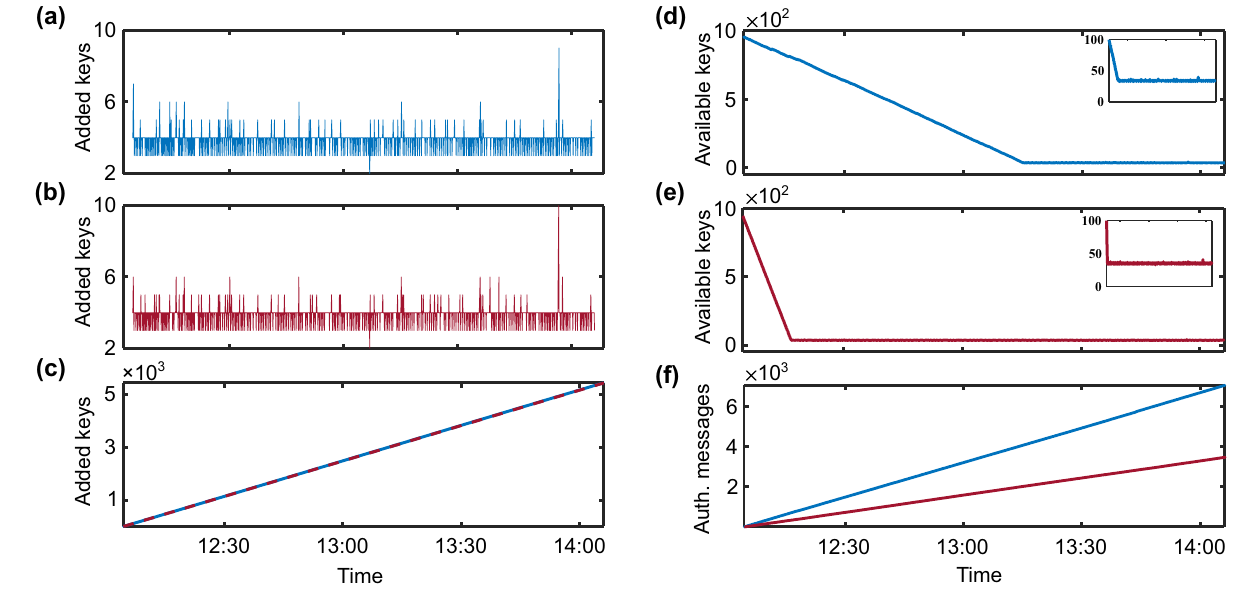
Figure 6. Polled every 5 seconds ( a ) Number keys added to the Intel Agent system. ( b ) Number keys added to the Pv Agent system. ( c ) Total number of the added keys to the Intel (blue) and Pv (red) agents. The number of keys available to ( d ) The Intel agent and ( e ) The Pv agent. The inset figure shows the minimum keys that each agent must maintain (30 keys, which we chose arbitrarily) to synchronize the secret keys. ( f ) The number of authenticated messages by the Intel (blue) and PV (red)